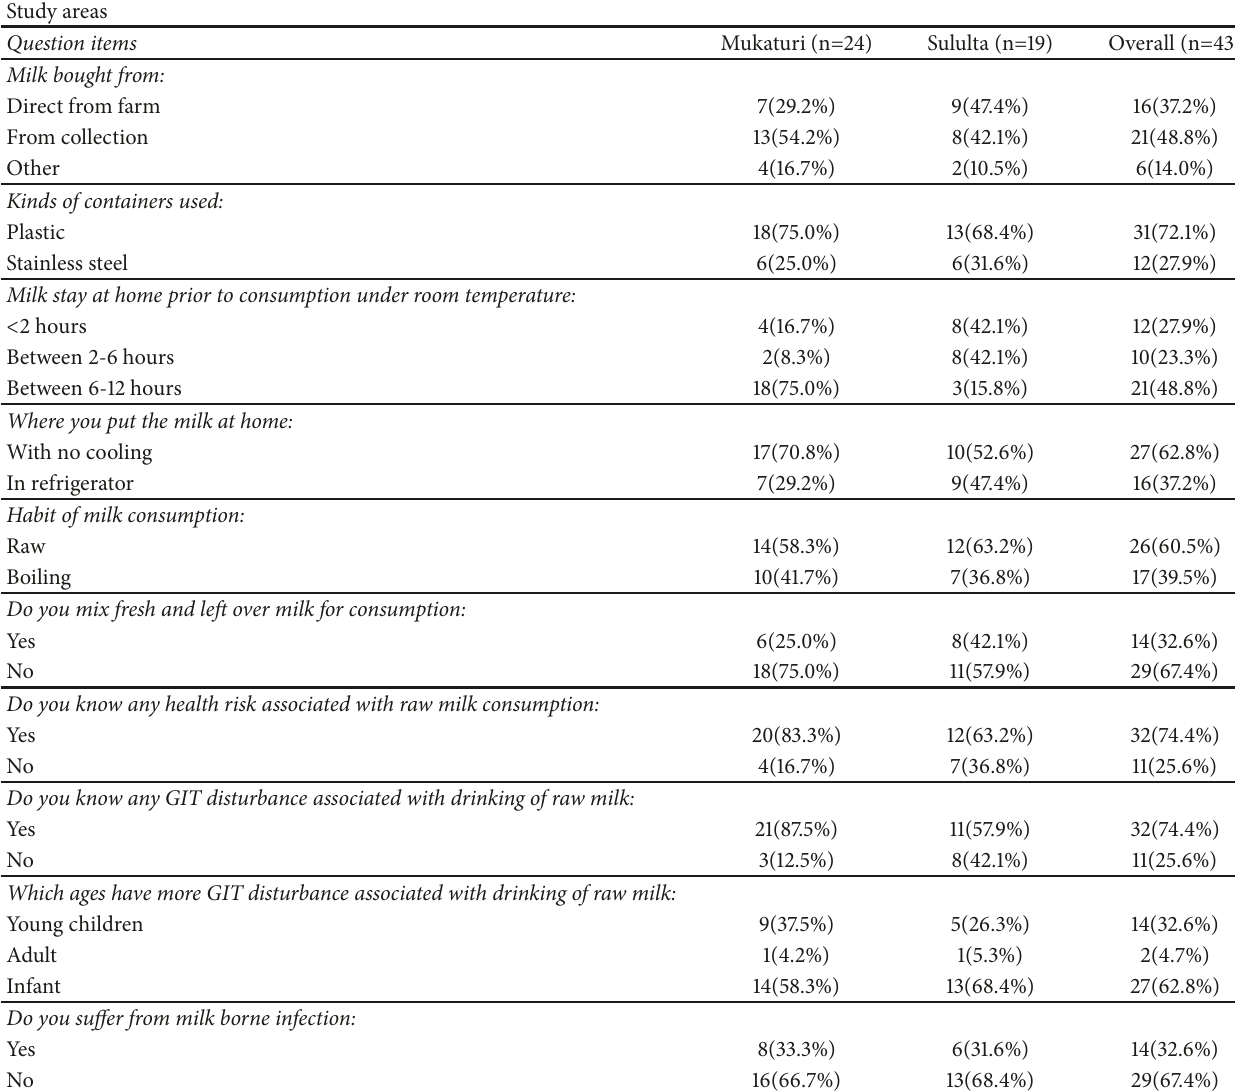
Table 2: Information on milk consuming/use and milk handling activity by consumer in the study areas. Study